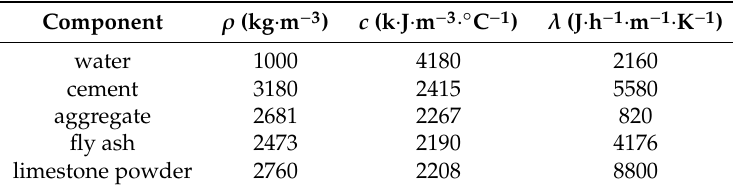
Table 4. The basic parameters of the hydrothermal